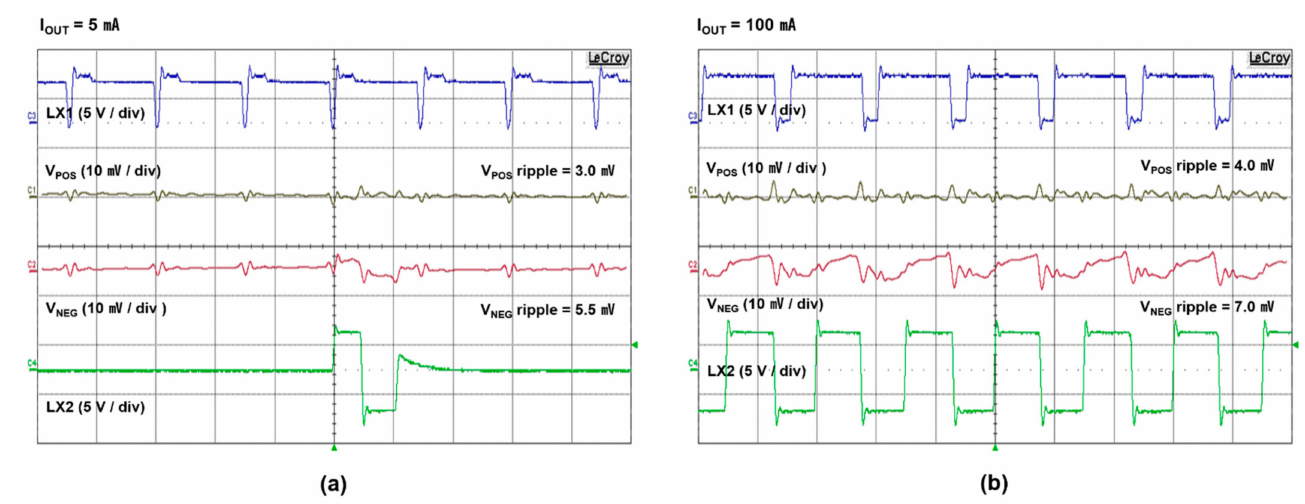
Figure 13. Ripple waveforms of V POS and V NEG : ( a ) I OUT = 5 mA; ( b ) I OUT = 100 mA.